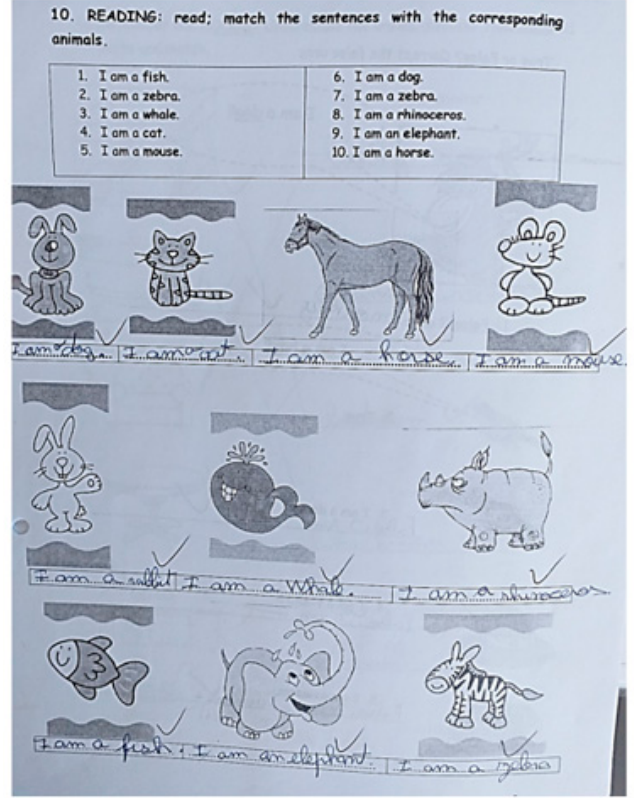
Figure 2. L2 Reading, matching and writing.